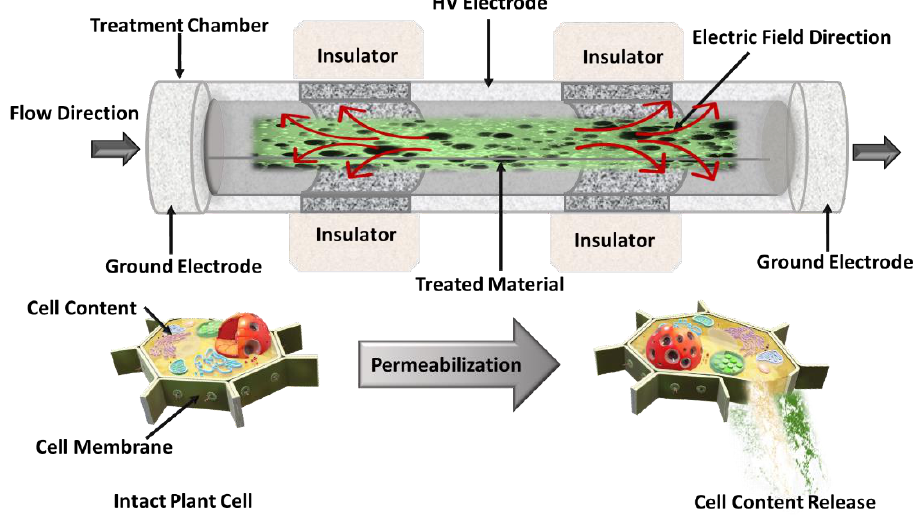
Figure 5. Schematic representation of a continuous co-filed PEF treatment chamber. Andreou et al. (2020) applied PEF technology in three different stages of industrial tomato processing, including peeling, juice extraction, and tomato waste valorization. The recovery of high-added-value compounds from residues of the juicing process assisted by PEF was investigated. As a result, the application of PEF at 2 kV/cm and 700 pulses enhanced the extraction yield of carotenoids by 56.4% and doubled the concentration of total phenolics compared to the untreated samples